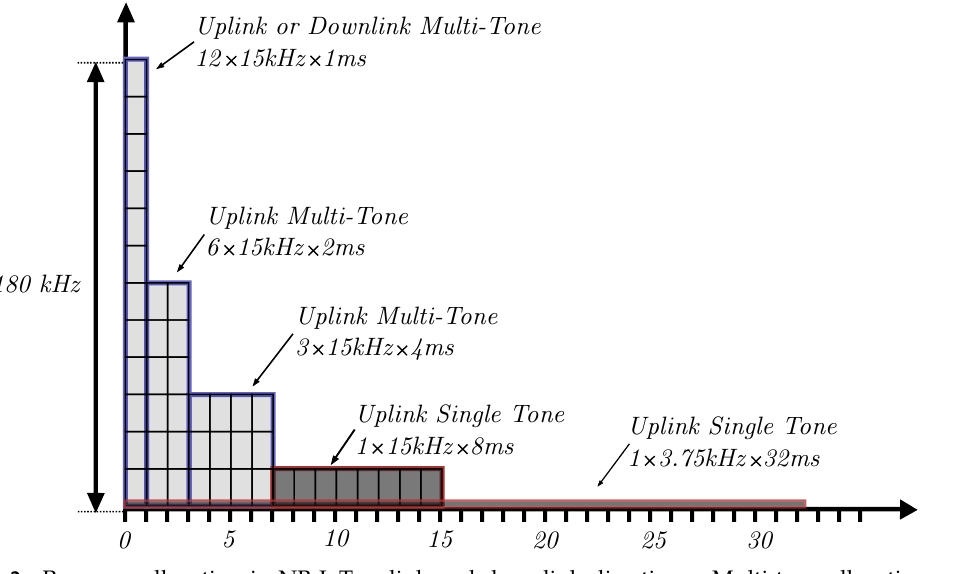
Figure 3. Resource allocation in NB-IoT uplink and downlink directions. Multi-tone allocations are highlighted in light gray with blue borders, and single tone allocations are dark gray with red